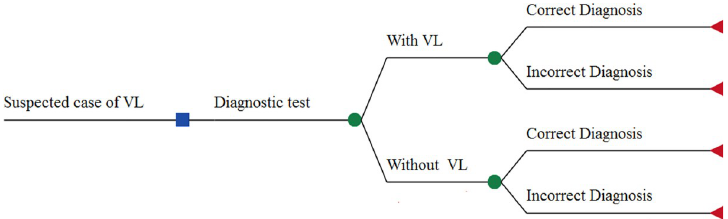
Fig 1. Basic structure of the decision tree used to compare diagnostic tests in suspected cases of visceral leishmaniasis in a reference center for the